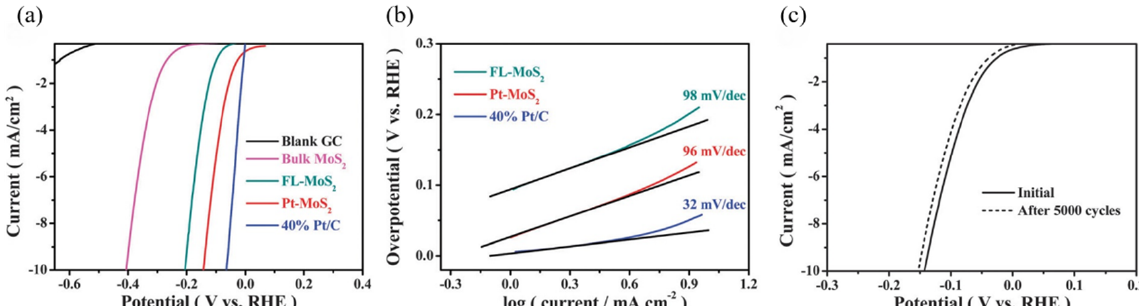
Figure 10. ( a ) HER polarization curves of Pt–MoS 2 , blank glassy carbon (GC) electrode, bulk MoS 2 , few-layer (FL)-MoS 2 , and 40% Pt/C, respectively. ( b ) Tafel plots of FL-MoS 2 (98 mV dec − 1 ), Pt–MoS 2 (96 mV dec − 1 ), and 40% Pt/C (32 mV dec − 1 ). ( c ) The polarization stability tests of Pt–MoS 2 between 0.13 and +0.57 V (vs. reversible hydrogen electrode (RHE)) at 100 mV s − 1 (solid line: Initial state; broken line: After 5000 cycles of CV scans) [44].